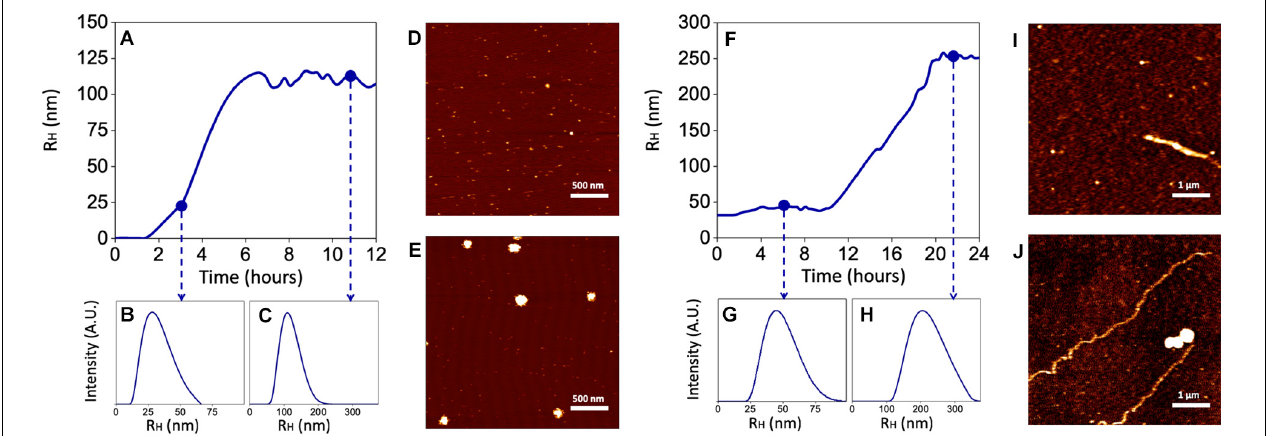
FIGURE 6 | Kinetics of A β aggregation and oligomer/fibril formation by Dynamic Light Scattering (DLS) and Atomic Force Microscopy (AFM). 25 nM sA β or 6.25 nM fA β were incubated in cell culture medium at 37 ◦ C for 24 h under quiescent conditions. At fixed time points, A β samples were drop casted of fresh cleaved Mica disks and air dried. (A–C) Show a representative monomers aggregation kinetics of 25 nM sA β , measured by DLS. (D,E) Representative AFM micrographs of early oligomers (D) and oligomers after 12 h of aggregation (E) are reported. (F–H) 6.25 nM fA β aggregation kinetics, assessed by DLS, are reported. Representative AFM images of fibrils before (I) and after (J) aggregation are reported with monomers and oligomers coexisting with fibrils in the final